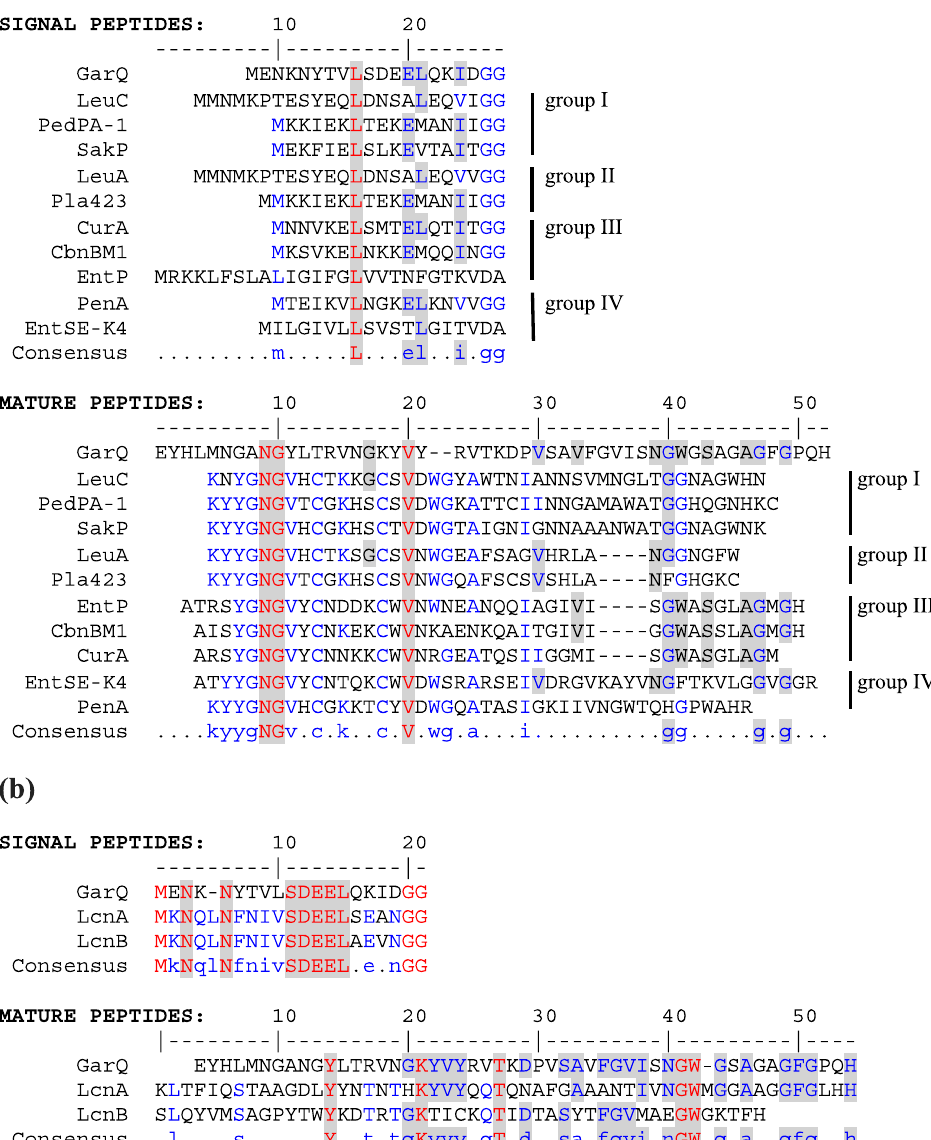
Figure 4. Multiple sequence alignment of the amino acid sequences of signal peptides and mature peptides of garvicin Q and class IIa (pediocin-like) ( a ) and LcnA-like class IId ( b ) bacteriocins targeting Man-PTS. Full consensus and low consensus amino acids are indicated with red and blue letters, respectively. In a bacteriocin and consensus sequence the amino acids conserved among class IIa or LcnA-like class IId bacteriocins are not shaded, whereas the ones conserved between GarQ and class IIa or LcnA-like class IId bacteriocins are highlighted grey. The UniProt accession numbers are P38579 for carnobacteriocin BM1 (CbnBM1), P0A311 for curvacin A (CurA), O30434 for enterocin P (EntP), C9B989 for enterocin SE-K4 (EntSE-K4), H6U5Y1 for garvicin Q, P0A313 for lactococcin A (LcnA), P35518 for lactococcin B (LcnB), P34034 for leucocin A (LeuA), H2EST2 for leucocin C (LeuC), P29430 for pediocin PA-1 (PedPA-1), M1GJX1 for penocin A (PenA), Q93FV7 for plantaricin 423 (Pla423) and P35618 for sakacin P